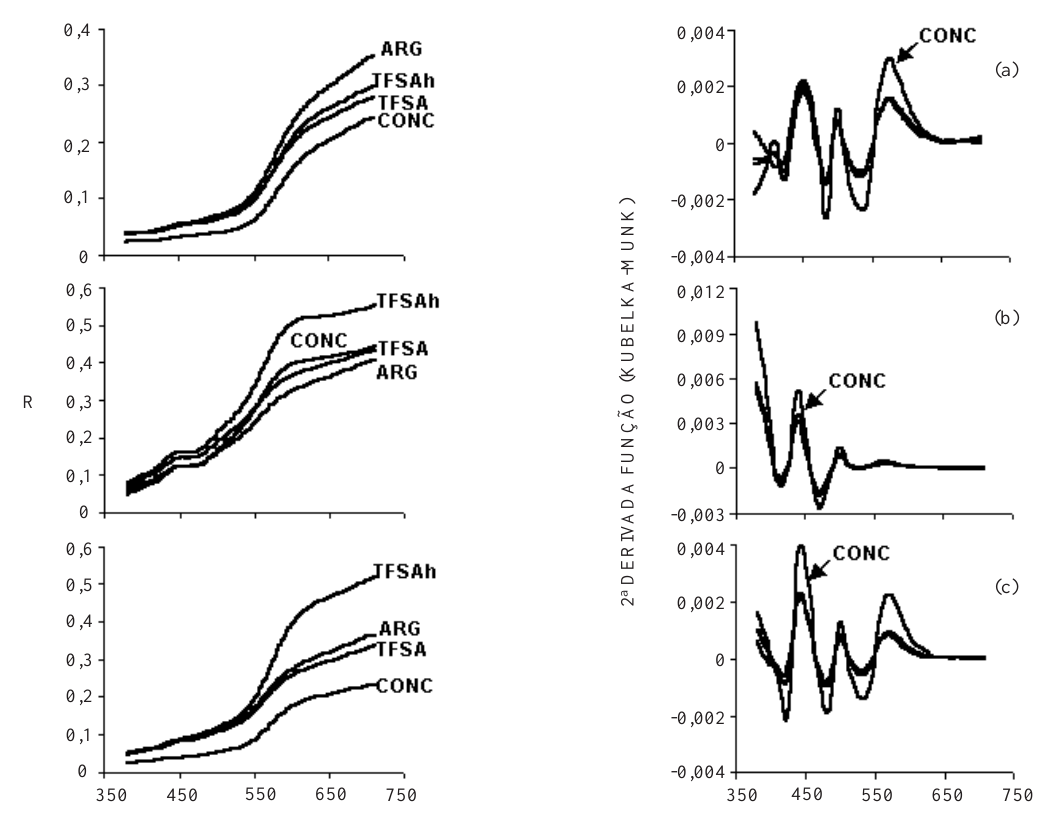
Figura 4. Espectros de refletância difusa e correspondente segunda derivada da função Kubelka-Munk (f(KM)) para a terra fina seca ao ar (TFSA) e terra fina tratada para a eliminação de matéria orgânica (TFSAh), fração argila (ARG) e fração argila concentrada em óxidos de ferro (CONC) dos solos: a) LV (S1a), b) LVA (S9a) e c) LV (S13a).